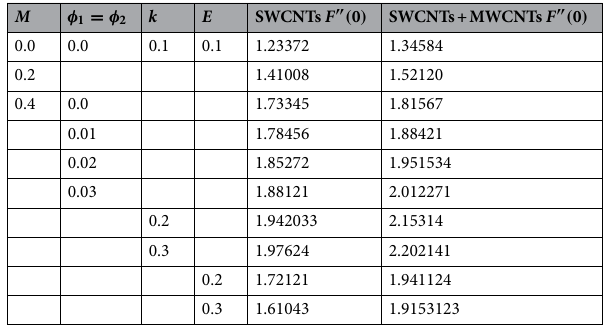
0.5 x versus various parameters for the blood base hybrid nanofluid.